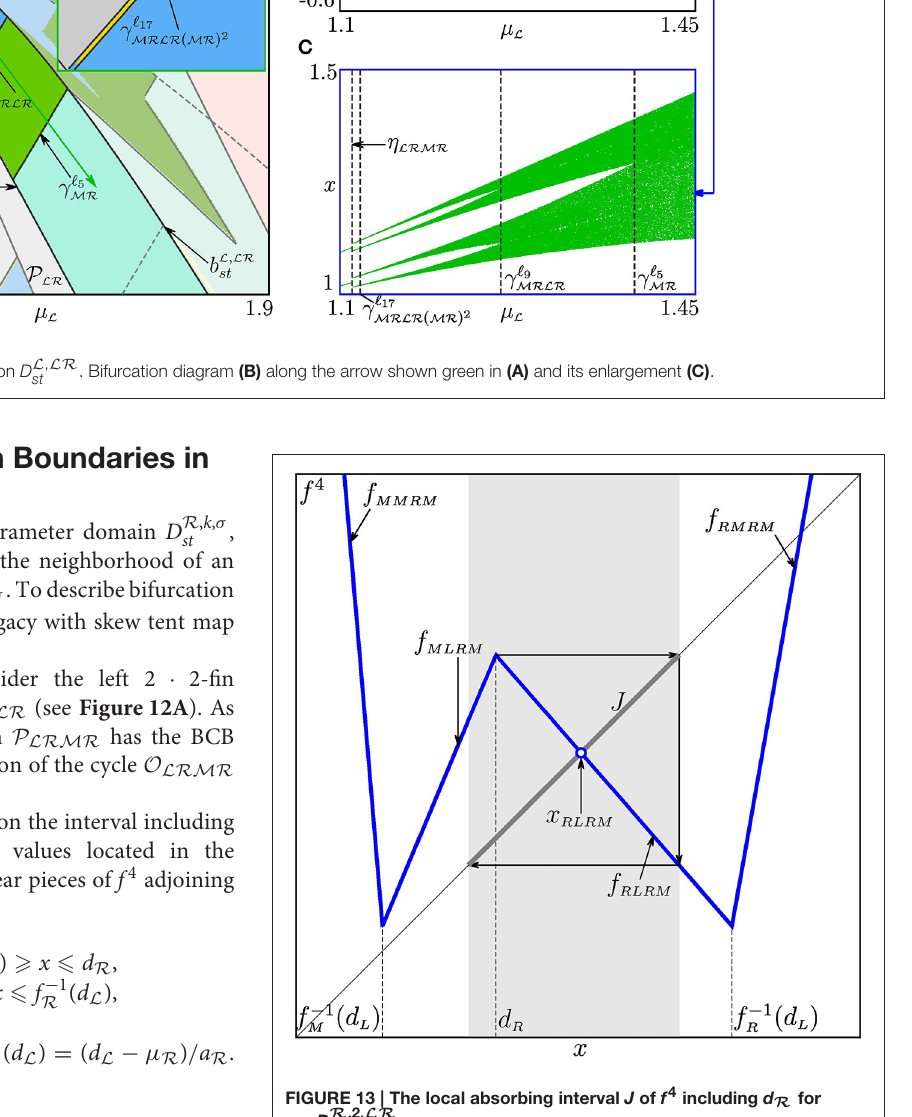
FIGURE 13 | The local absorbing interval J of f 4 including d R for p ∈ D R ,2, LR